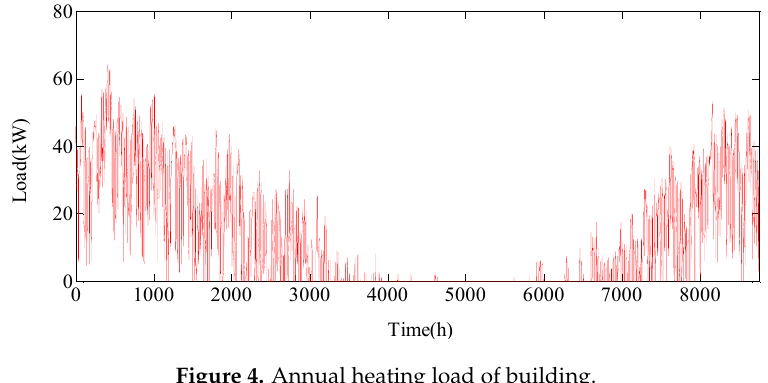
Figure 4. Annual heating load of building.